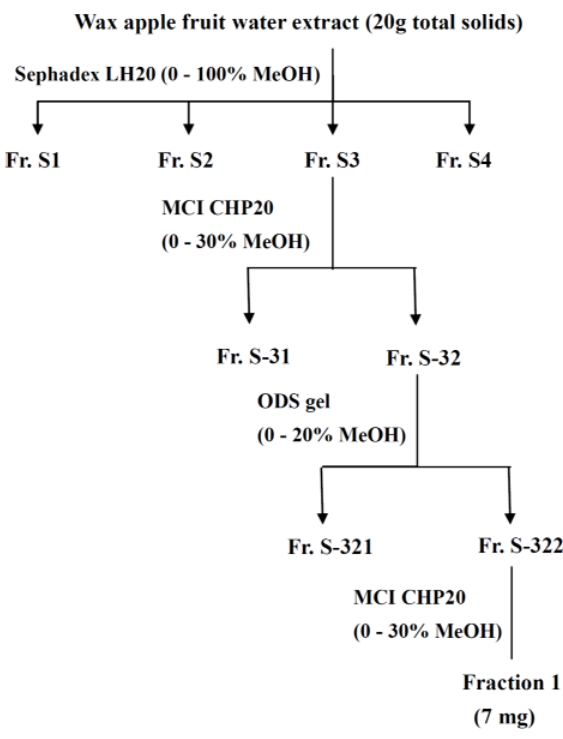
Figure 1. The flow chart for fractionation of wax apple fruit water